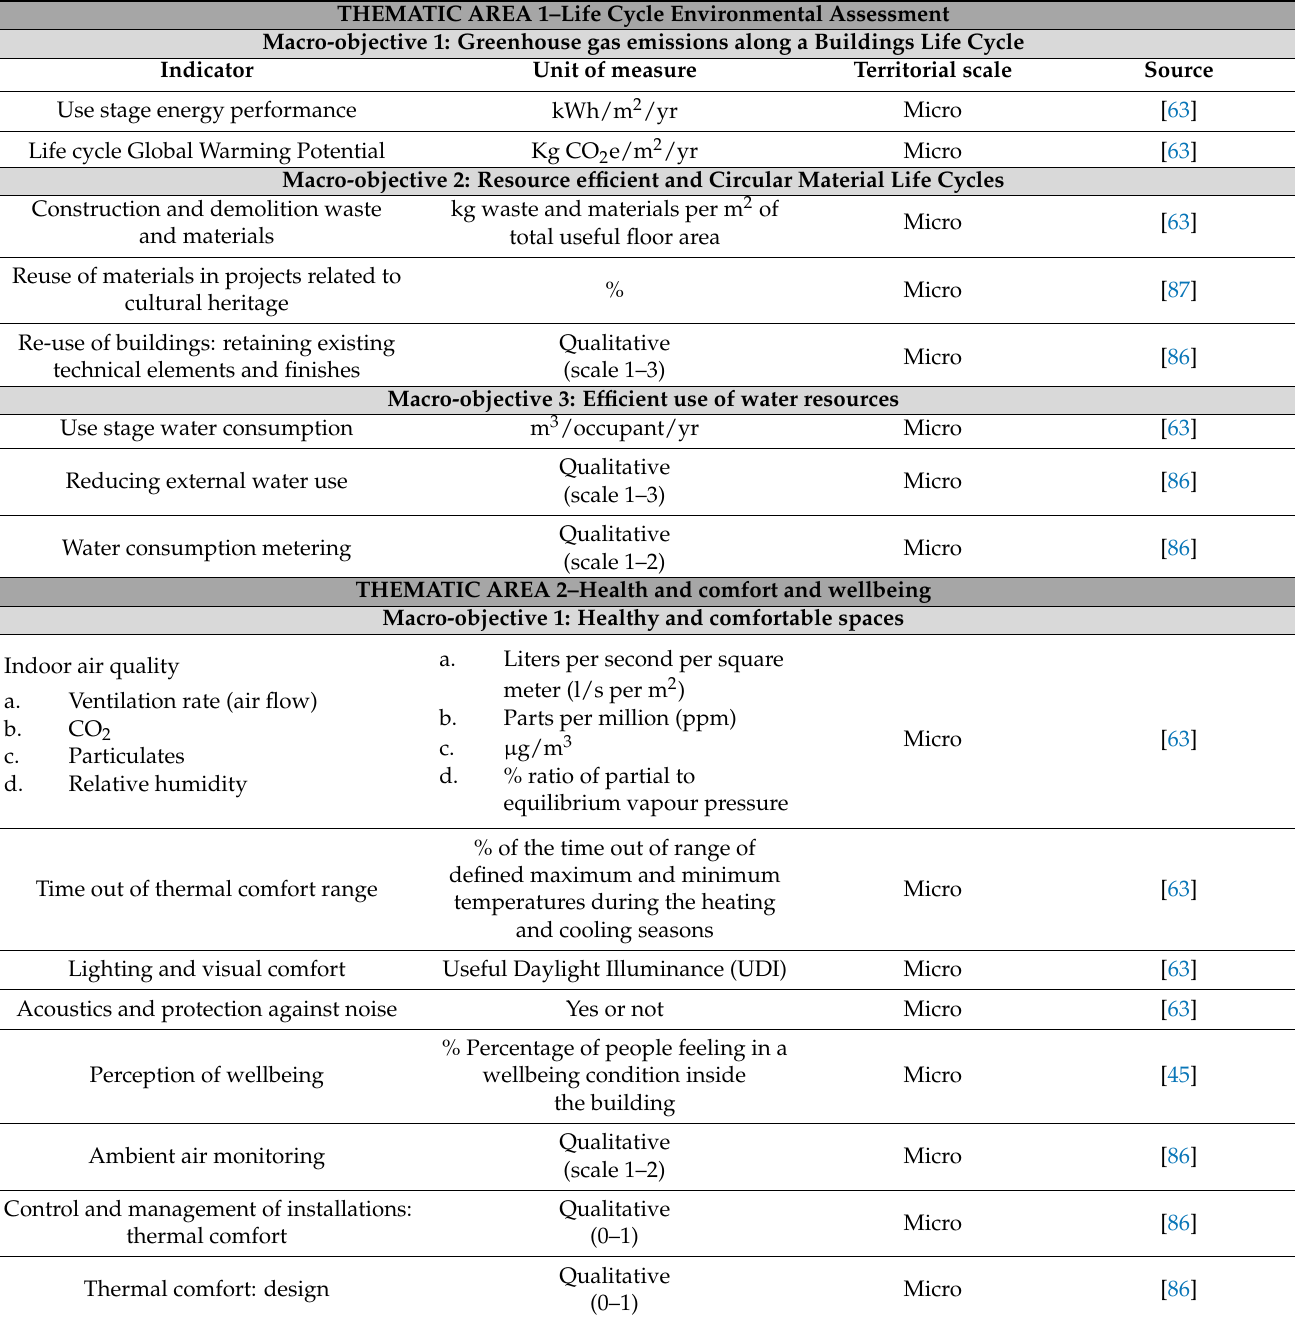
Table 3. Indicators of the proposed evaluation framework